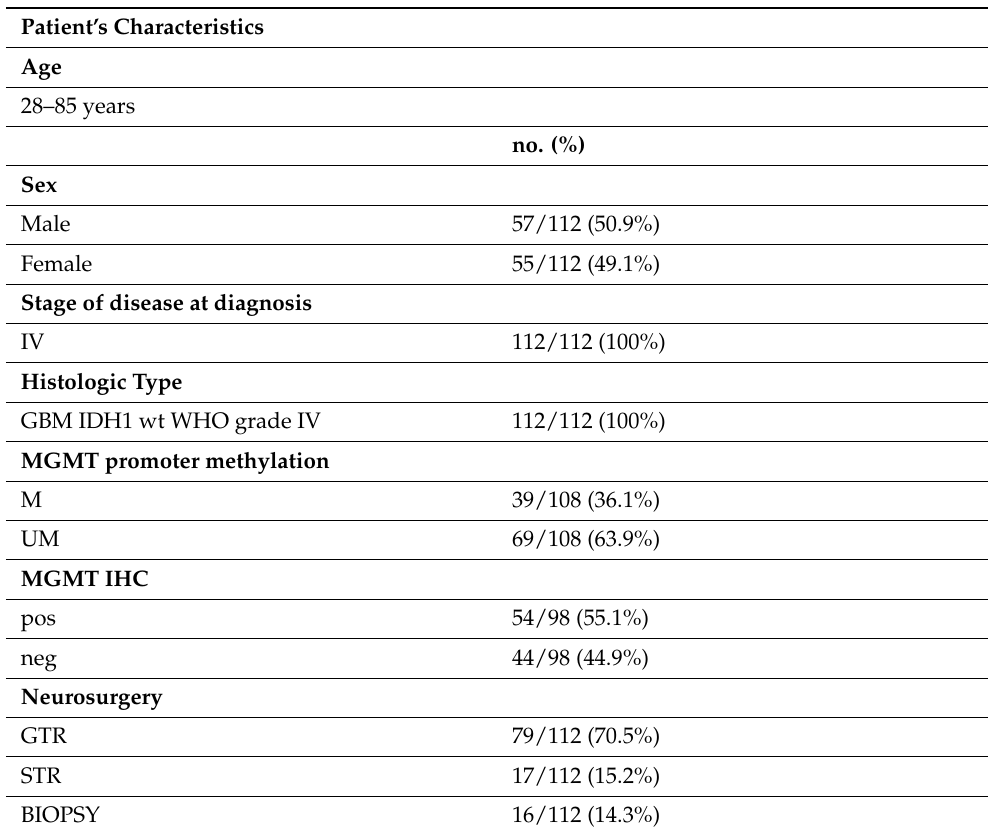
Table 1. Patients’